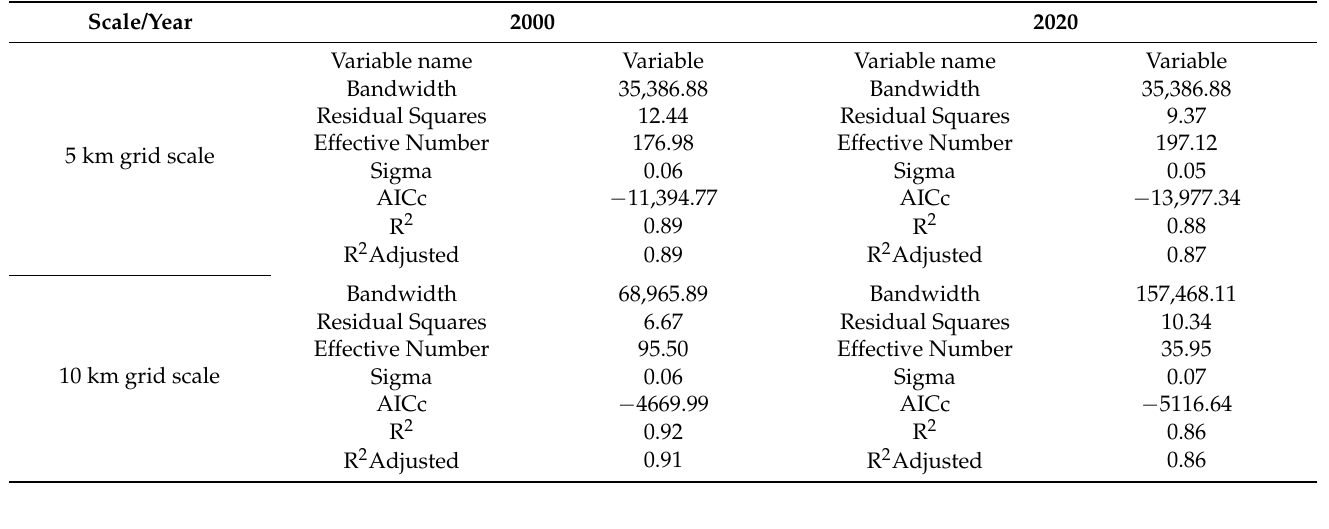
Table 3. Test result of the GWR model.